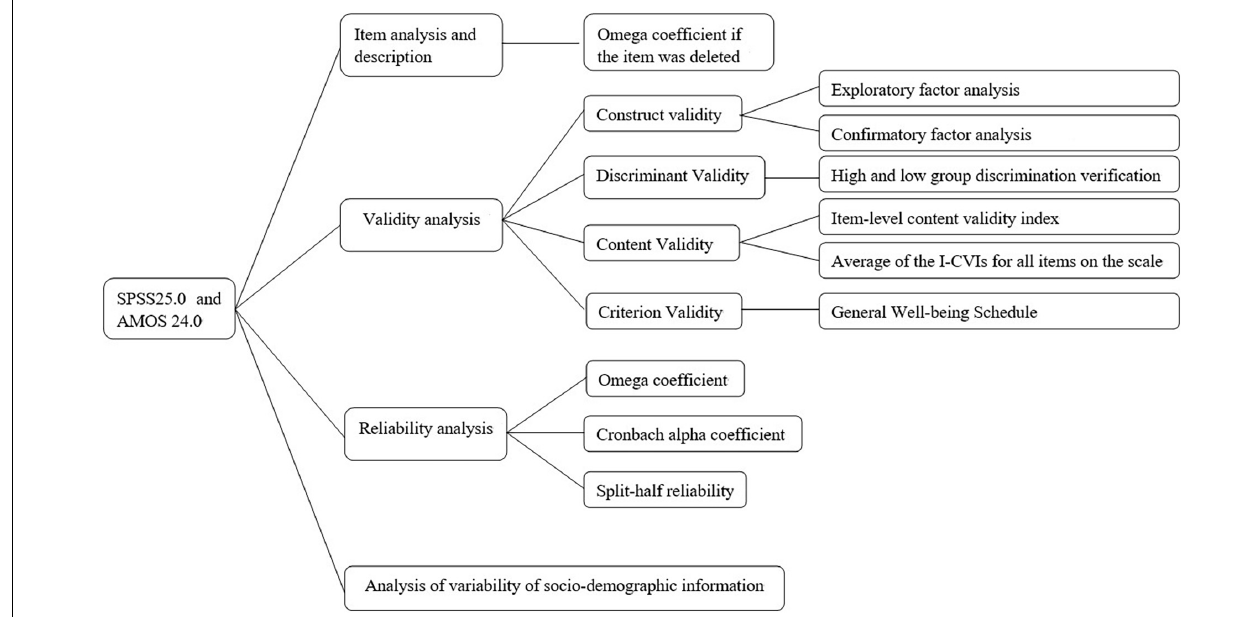
FIGURE 1 | China Revision of the Pitt Wellness Scale data analysis